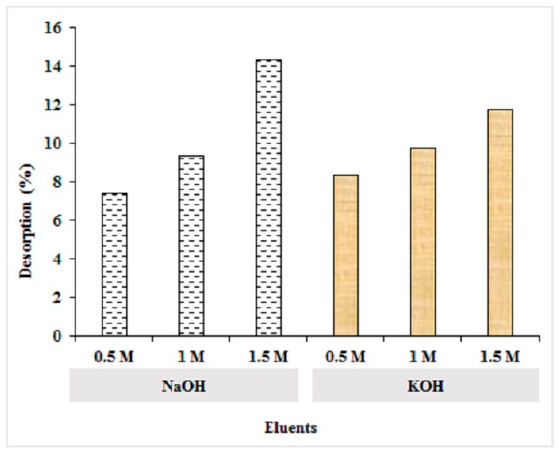
Figure 12. Desorption of MA-AC400 adsorbent.